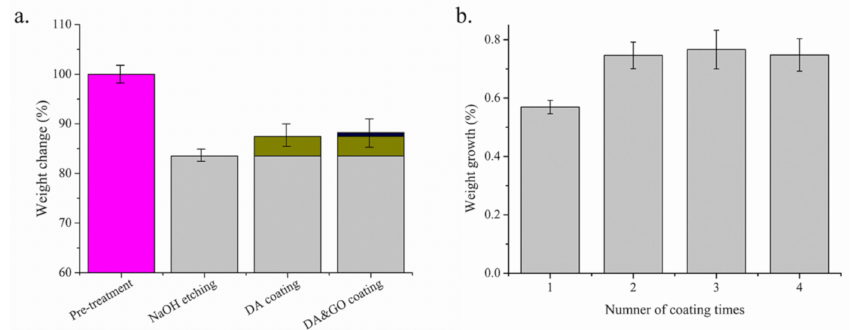
Figure 7. Weight change of the surgical sutures. ( a ) Weight change of the multifilament surgical sutures treated with di ff erent treatments; ( b ) weight change of the multifilament surgical sutures with a GO coating.